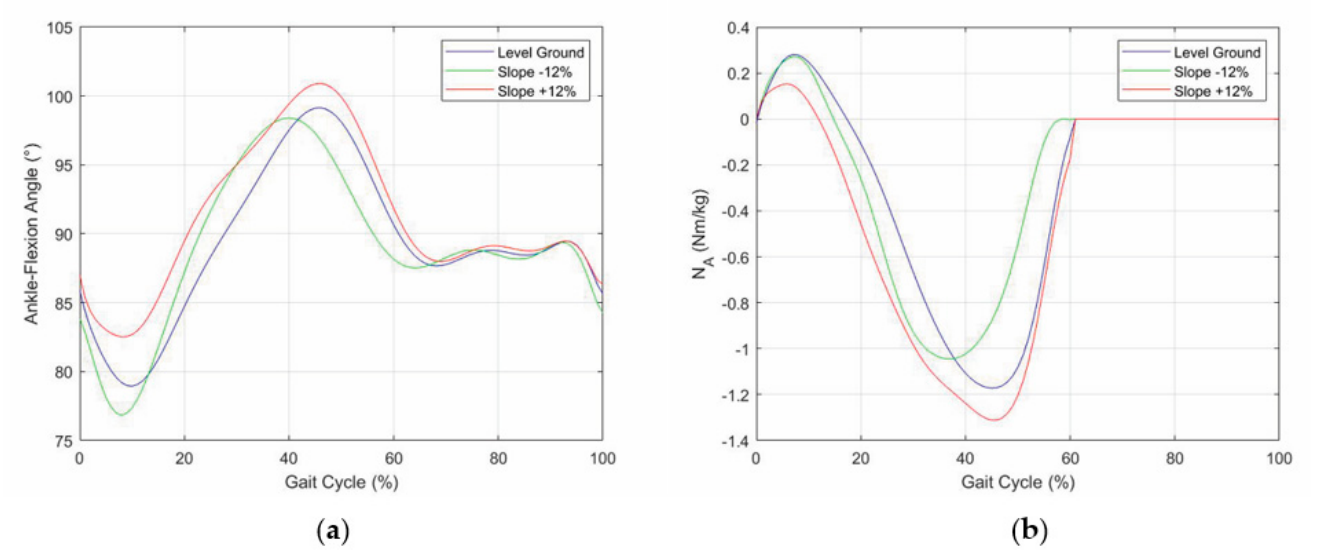
Figure 11. Prosthetic ankle data: ( a ) dorsi-plantar flexion angle and ( b ) ankle-joint torque.